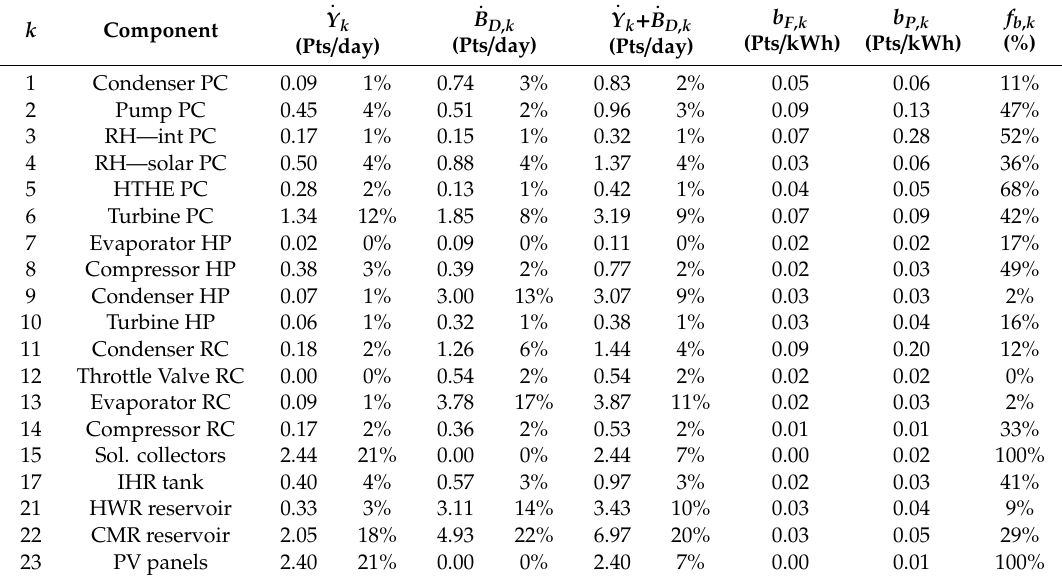
Table 7. Results of the exergo-environmental analysis on a reference day of